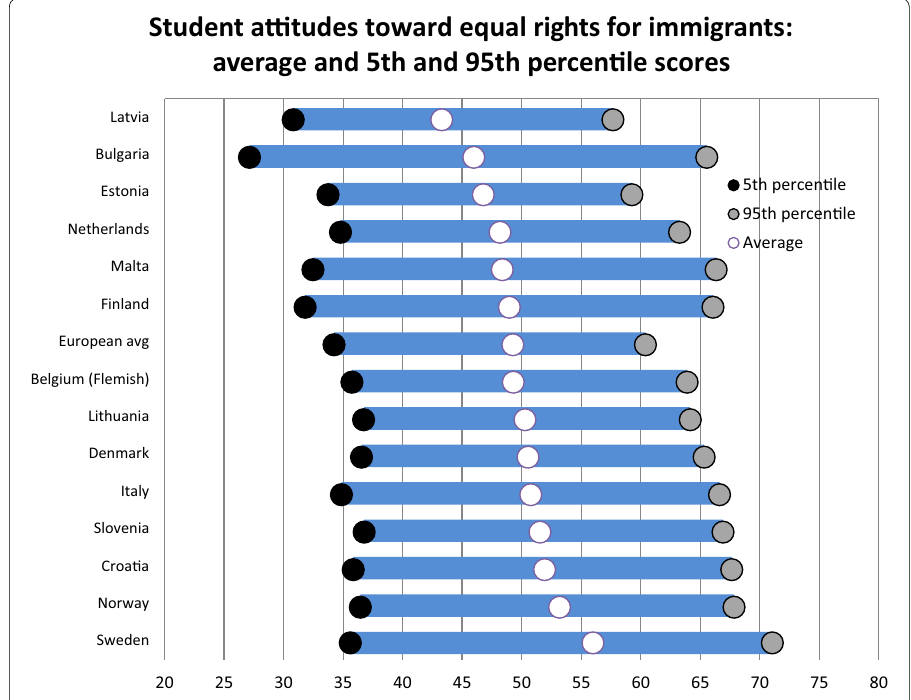
Fig. 2 Cross-country comparisons: average and 5th and 95th percentile